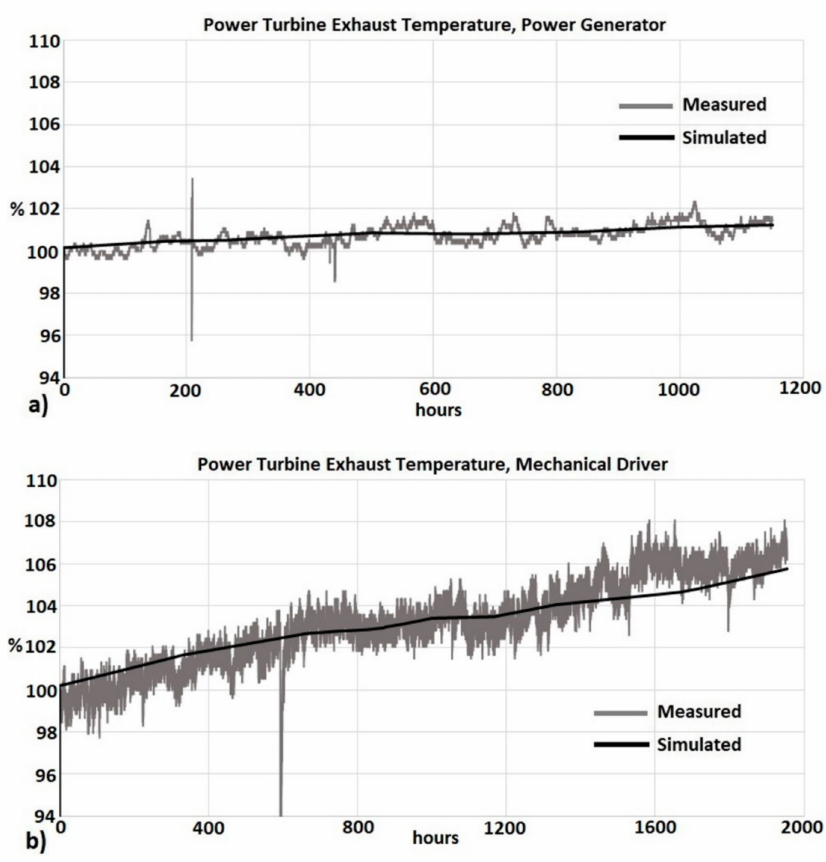
Figure 9. Measured and simulated power turbine exhaust temperatures: ( a ) power generator; ( b ) mechanical